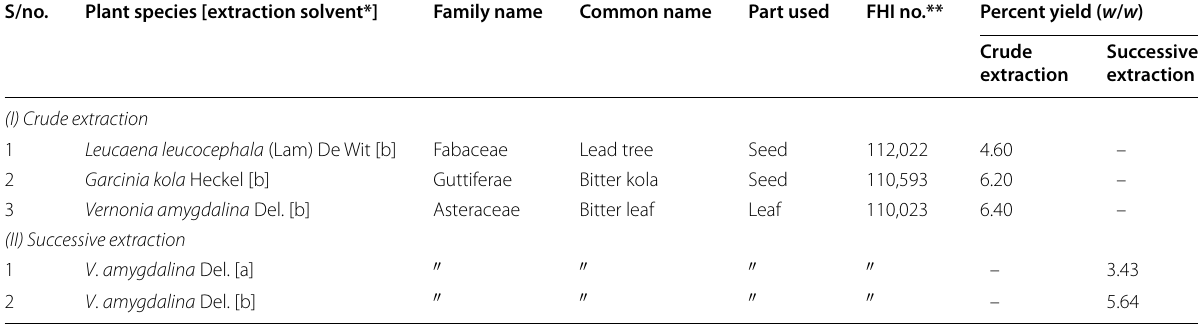
Table 2 Yield of FA-FD and lethal effect per fraction that kills 50% of Haemonchus placei